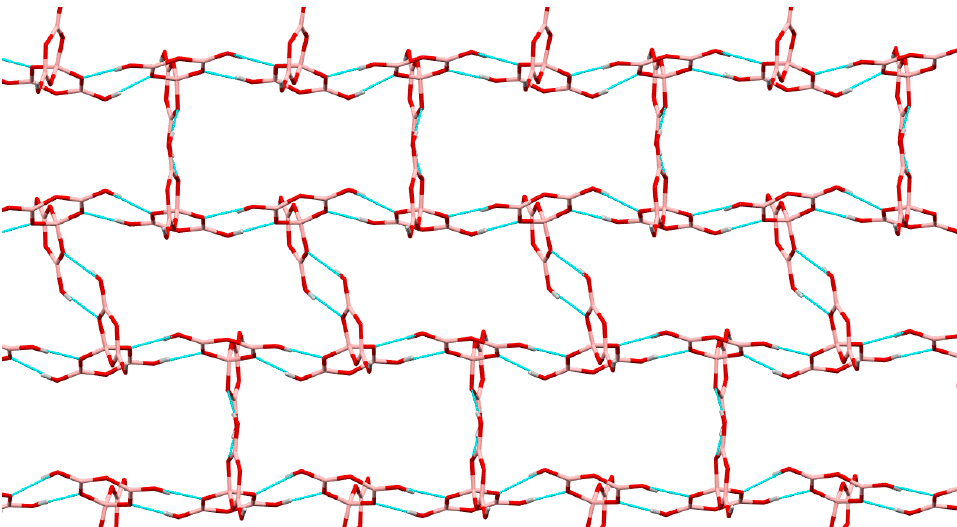
Figure 4. Giant lattice arising from pentaborate(1-)-pentaborate(1-) interactions in 8 , viewed along the c axis. Cations have been omitted for clarity, but are situated within rectangular ′ cavities ′ . Within this ′ plane ′ each pentaborate(1-) in shown H-bonding to 3 other pentaborate(1-) anions by R 22 (8) interactions. The C(8) Interaction (not shown) links these planes.